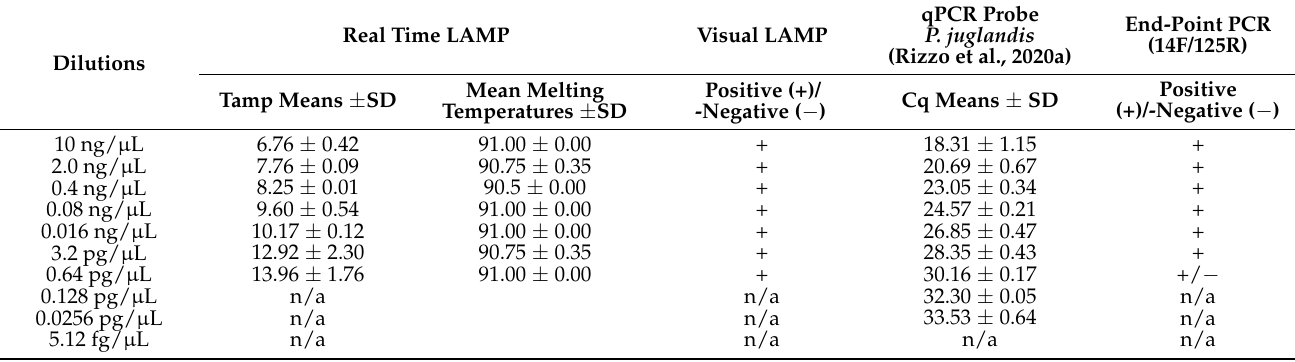
Table 3. LoD assay (comparison among different methods) based on WTB adults using 1:5 serial dilutions (from 10 ng/ µ L to 5.12 fg/ µ L) and the real-time LAMP protocol. The serial dilutions are the same ones used for the qPCR probe [31] and the Real Time and visual LAMP (this study).